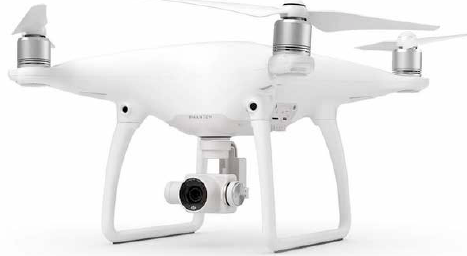
Figure 4. DJI Phantom 4. Source: www.dji.com